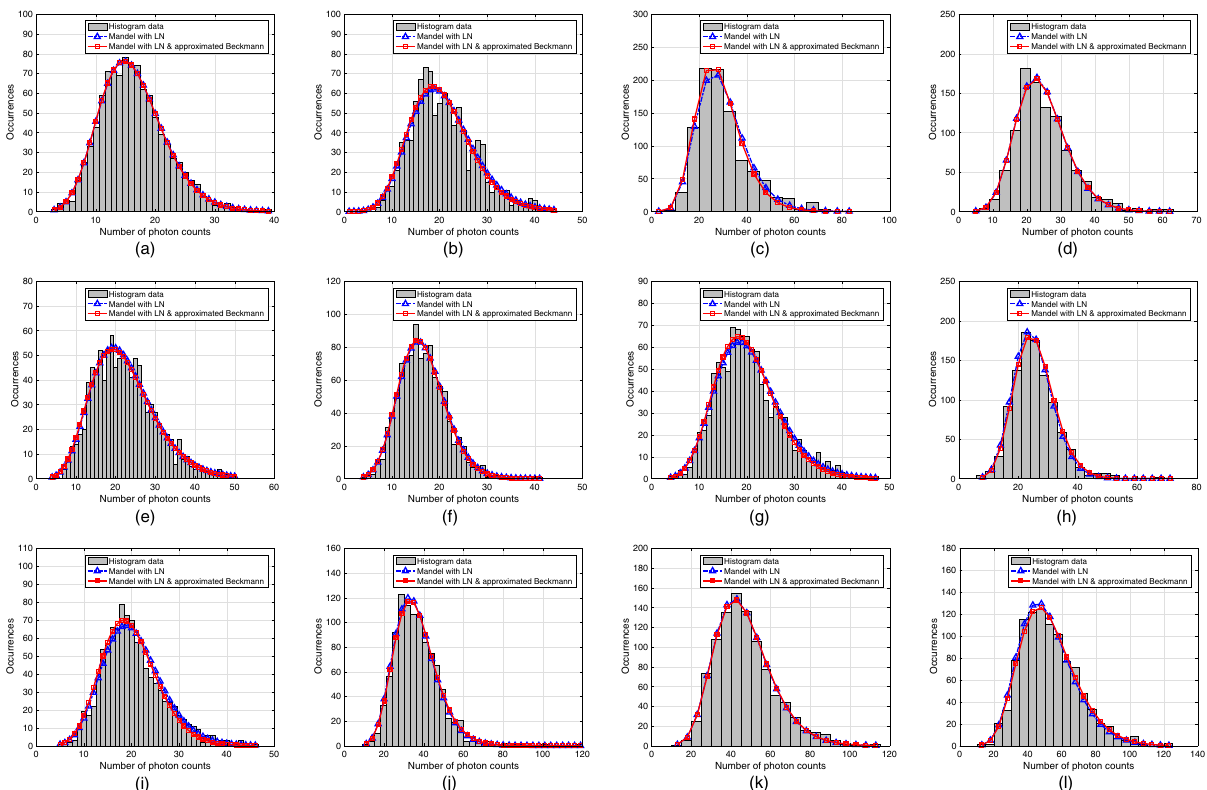
Fig. 4 Histograms and fi tted probability distribution models of 12 photon-count datasets. Each dataset contains the photon-count data during 1 s with a counting interval of 1 millisecond. From a to l , the gray bars represent histograms of the photon-count data, where the number of histogram bins is chosen by an automatic binning algorithm that returns bins with a speci fi c uniform width, which cover the range of elements in each dataset and reveal the underlying shape of the distribution. The dashed-dotted blue curve with triangle markers depicts the fi tted Mandel with log-normal (LN) distribution, and the solid red curve with square markers shows the fi tted Mandel with LN and approximated Beckmann distribution. Eq. (S3) in Supplementary Note 1 and Eq. (36) with the number of Laguerre polynomials J = 30 are respectively used to plot the Mandel with LN and the Mandel with LN and approximated Beckmann distributions. a dataset 1, bin width = 1. b dataset 2, bin width = 1. c dataset 3, bin width = 5. d dataset 4, bin width = 3. e dataset 5, bin width = 1. f dataset 6, bin width = 1. g dataset 7, bin width = 1. h dataset 8, bin width = 3. i dataset 9, bin width = 1. j dataset 10, bin width = 3. k dataset 11, bin width = 5. l dataset 12, bin width =